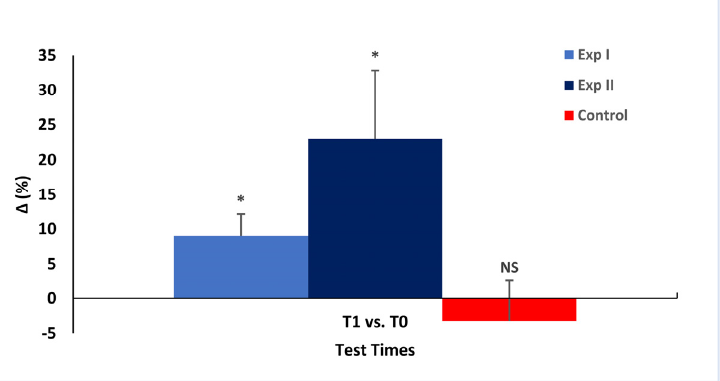
Figure 5. Mean values and standard deviations are shown. Chronic relative changes in the three groups. * Significant changes within the group (baseline: T0; T1: after 12 weeks of intervention; p < 0.05; NS: no